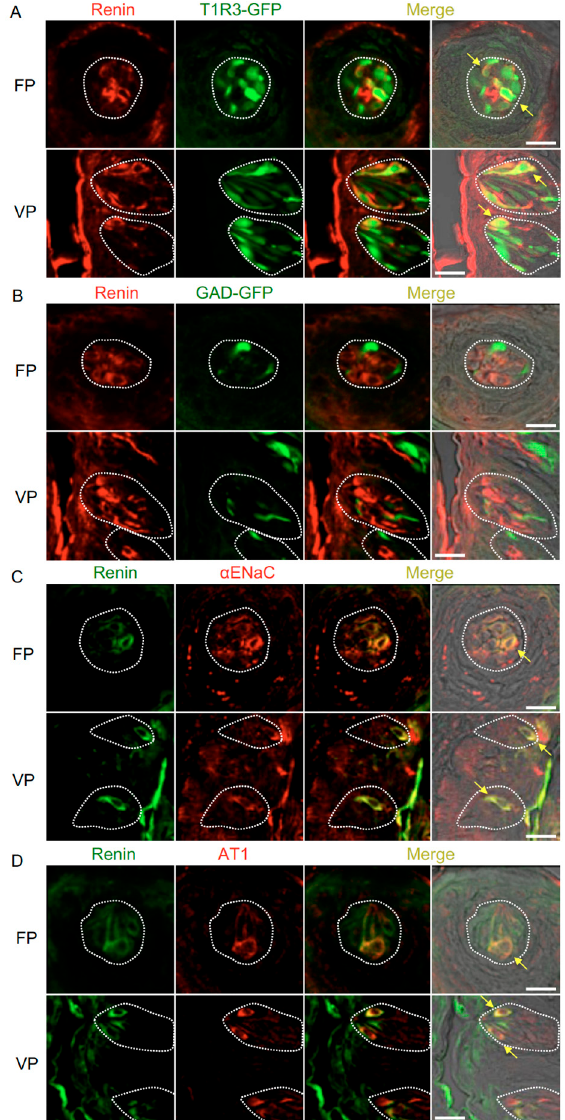
Figure 2. Co-expression of renin with taste receptor family 1 member 3 (T1R3), glutamate decarboxylase 67 (GAD), epithelial sodium channel α subunit ( α ENaC) or angiotensin II type 1 receptor (AT1) in taste bud cells. ( A ) Expression of renin in fungiform papillae (FP) and circumvallate papillae (VP) of T1R3-green fluorescent protein (GFP) mice. ( B ) Expression of renin in FP and VP of GAD67-GFP mice. ( C ) Co-expression of renin with α ENaC in FP and VP of B6 mice. ( D ) Co-expression of renin with AT1 in FP and VP of B6 mice. Immunostaining for renin is shown in red ( A,B ) or green ( C,D ). GFP fluorescence in T1R3-GFP and GAD67-GFP mice is shown in green ( A,B ). Immunostaining for α ENaC and AT1 is shown in red ( C,D ). The last merge panels: Nomarski images were overlaid with immunofluorescence (or GFP) merge images. Arrows indicate renin-expressing taste cells that co-express T1R3, α ENaC, or AT1. Dotted lines indicate the outlines of taste buds: scale bar, 25 μ m.